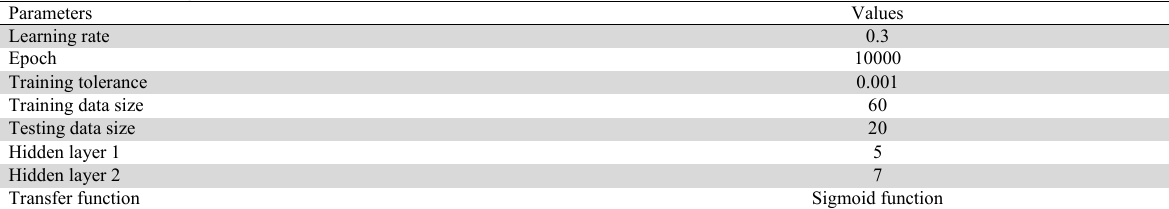
Parameter Settings Parameters